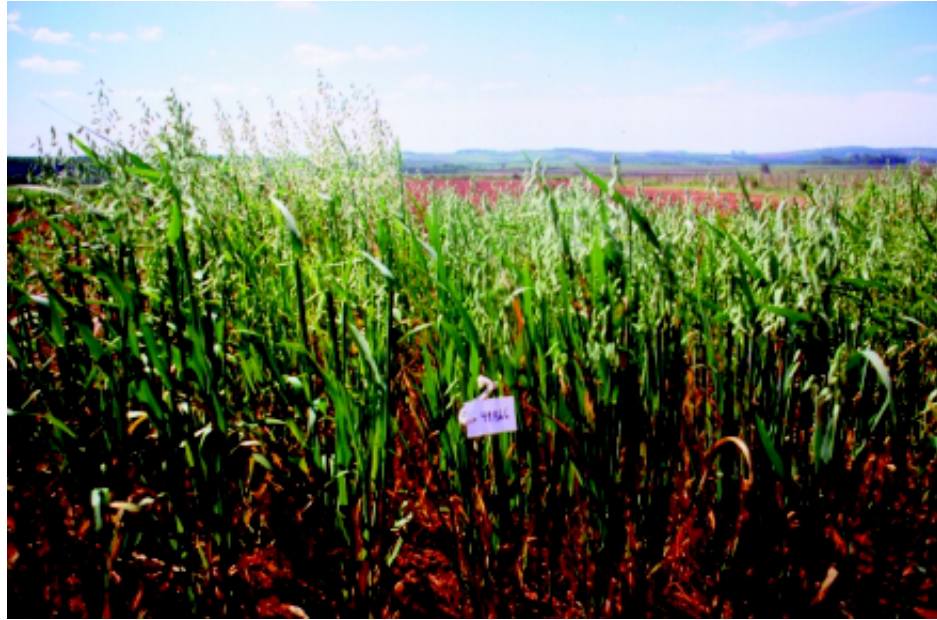
Figure 3 - Differences in plant height of UPF 12 (left) and somaclone 90VS046-B (right). EEA/UFRGS - 1994.